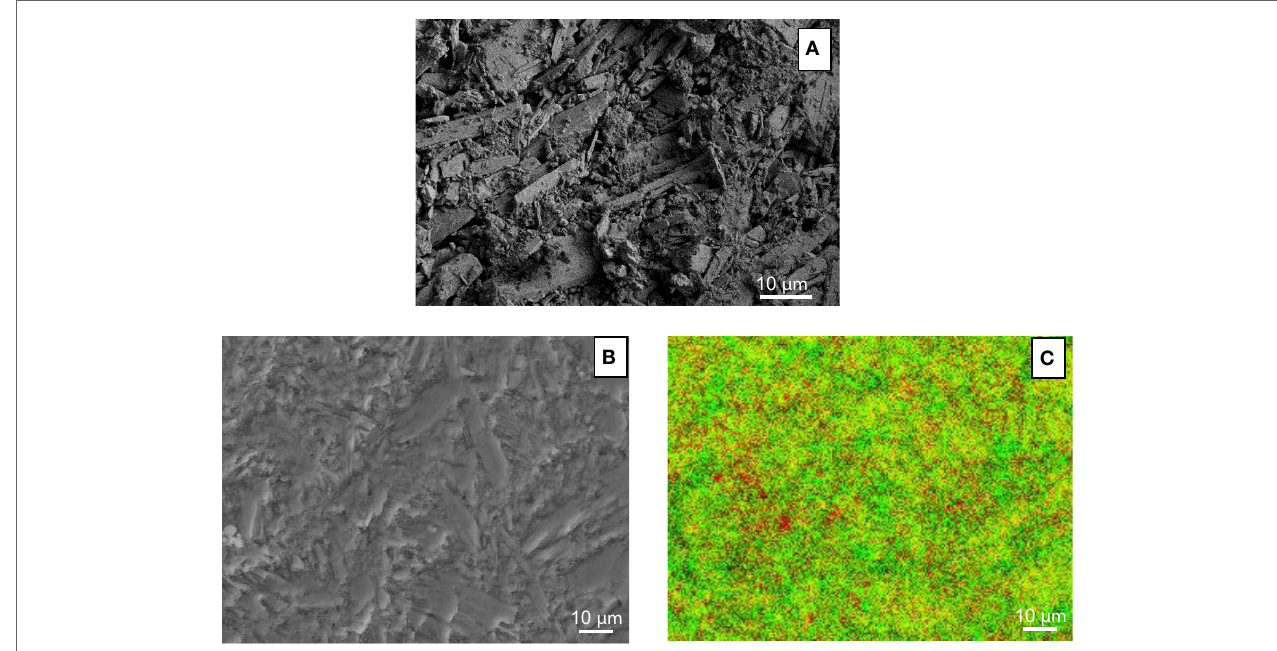
FigUre 5 | FeseM se images of (a) fractured surface of casiO 3 green body, (B) polished surface of 12-day of “solution replacement” compact, and (c) eDs chemical mapping of sample (B) . In (c) , yellow, red, and green represent CaSiO 3 , silica, and CaCO 3 , respectively.